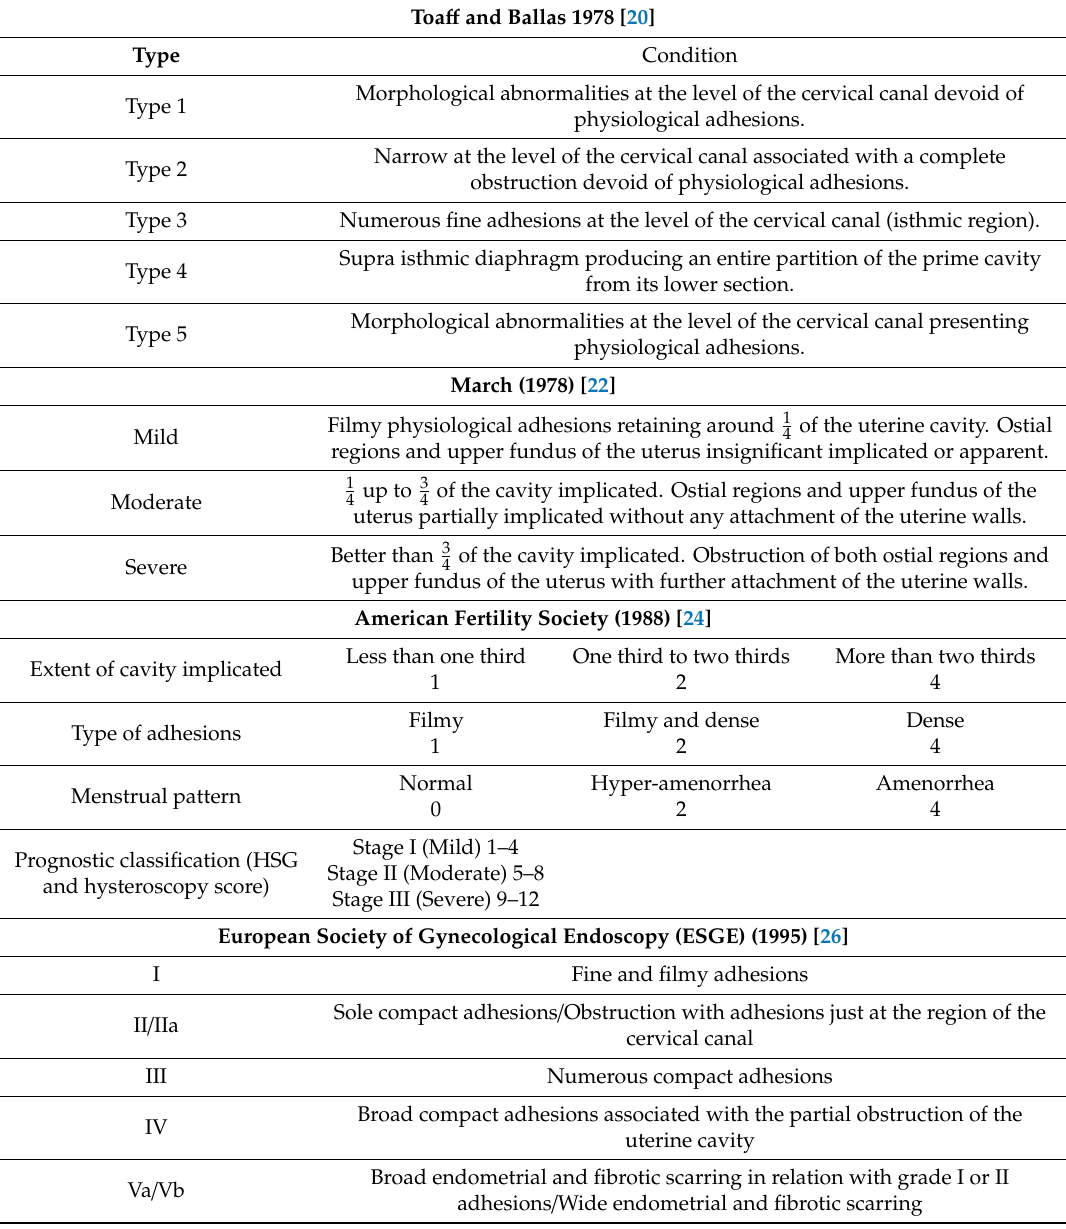
Table 1. Classification models for the Asherman